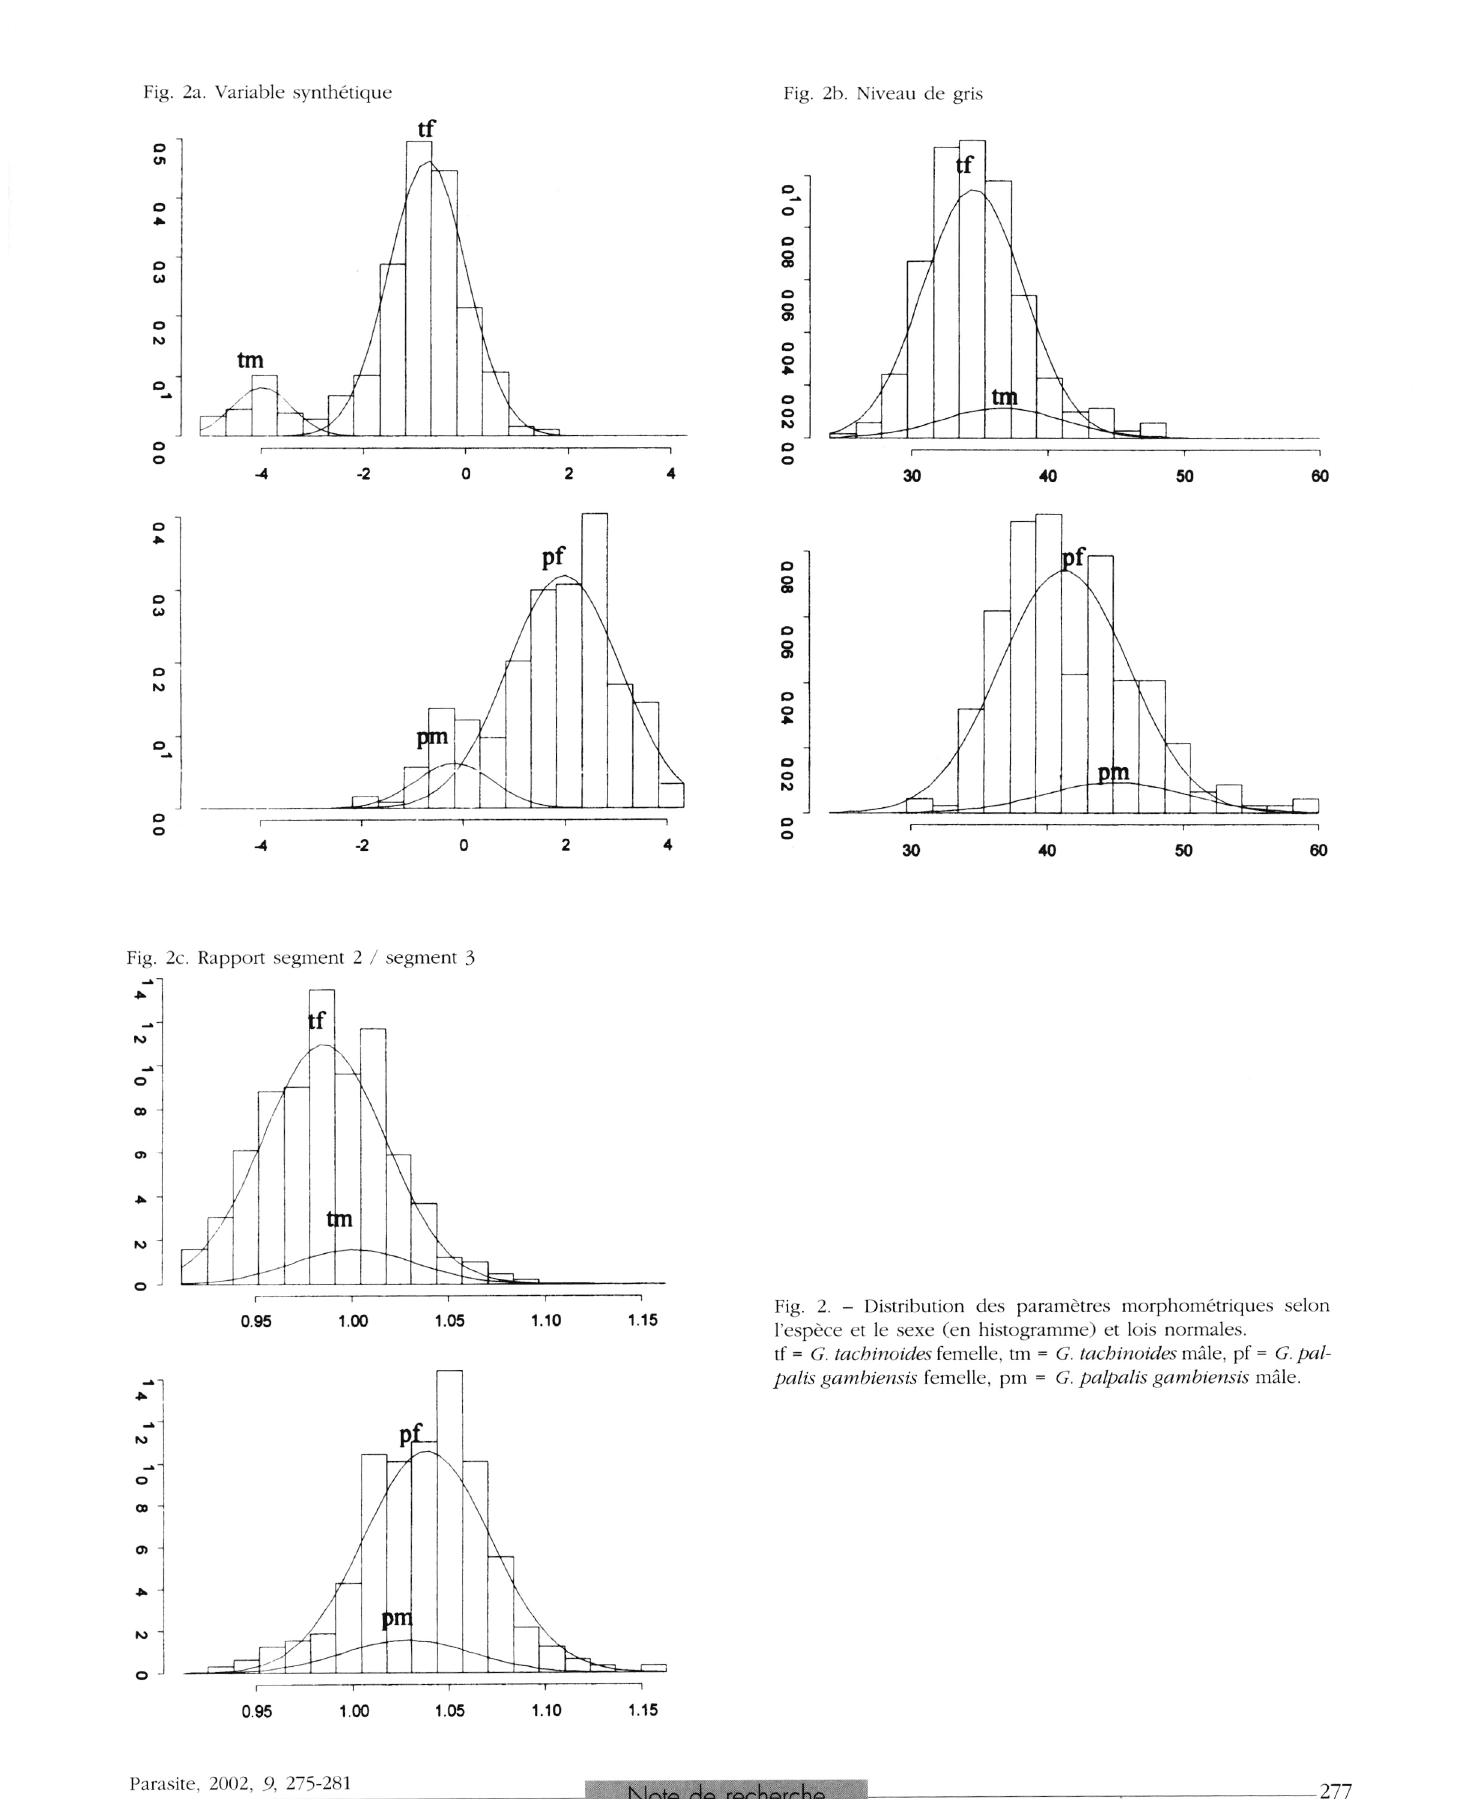
Fig. 2. - Distribution des paramètres morphométriques selon l'espèce et le sexe (en histogramme) et lois